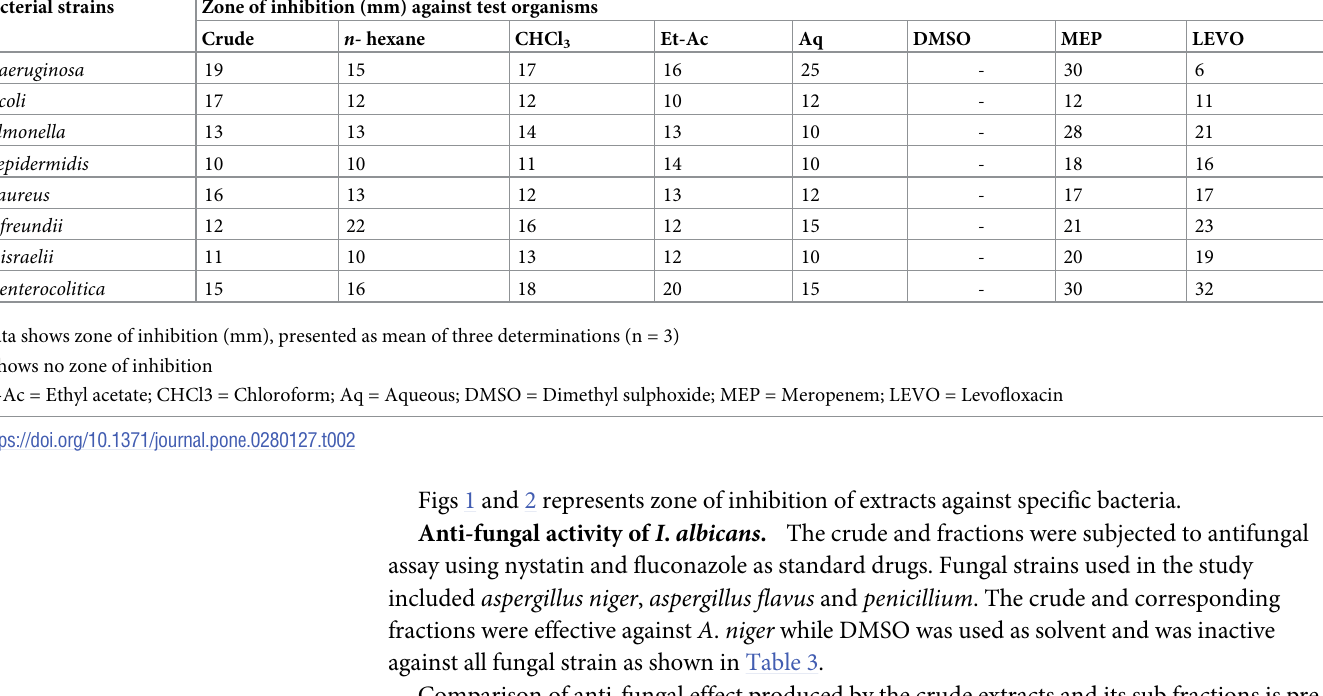
Table 2. Antibacterial activity of I . albicans crude and corresponding fractions. Bacterial